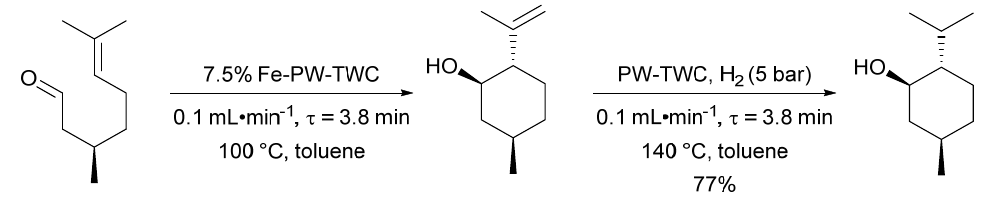
Figure 16. Application of PW-TWC material as an in-flow tandem cyclisation/hydrogenation catalyst. Residence time ( τ = catalyst cartridge volume/flow rate, Reproduced with permission from [111].